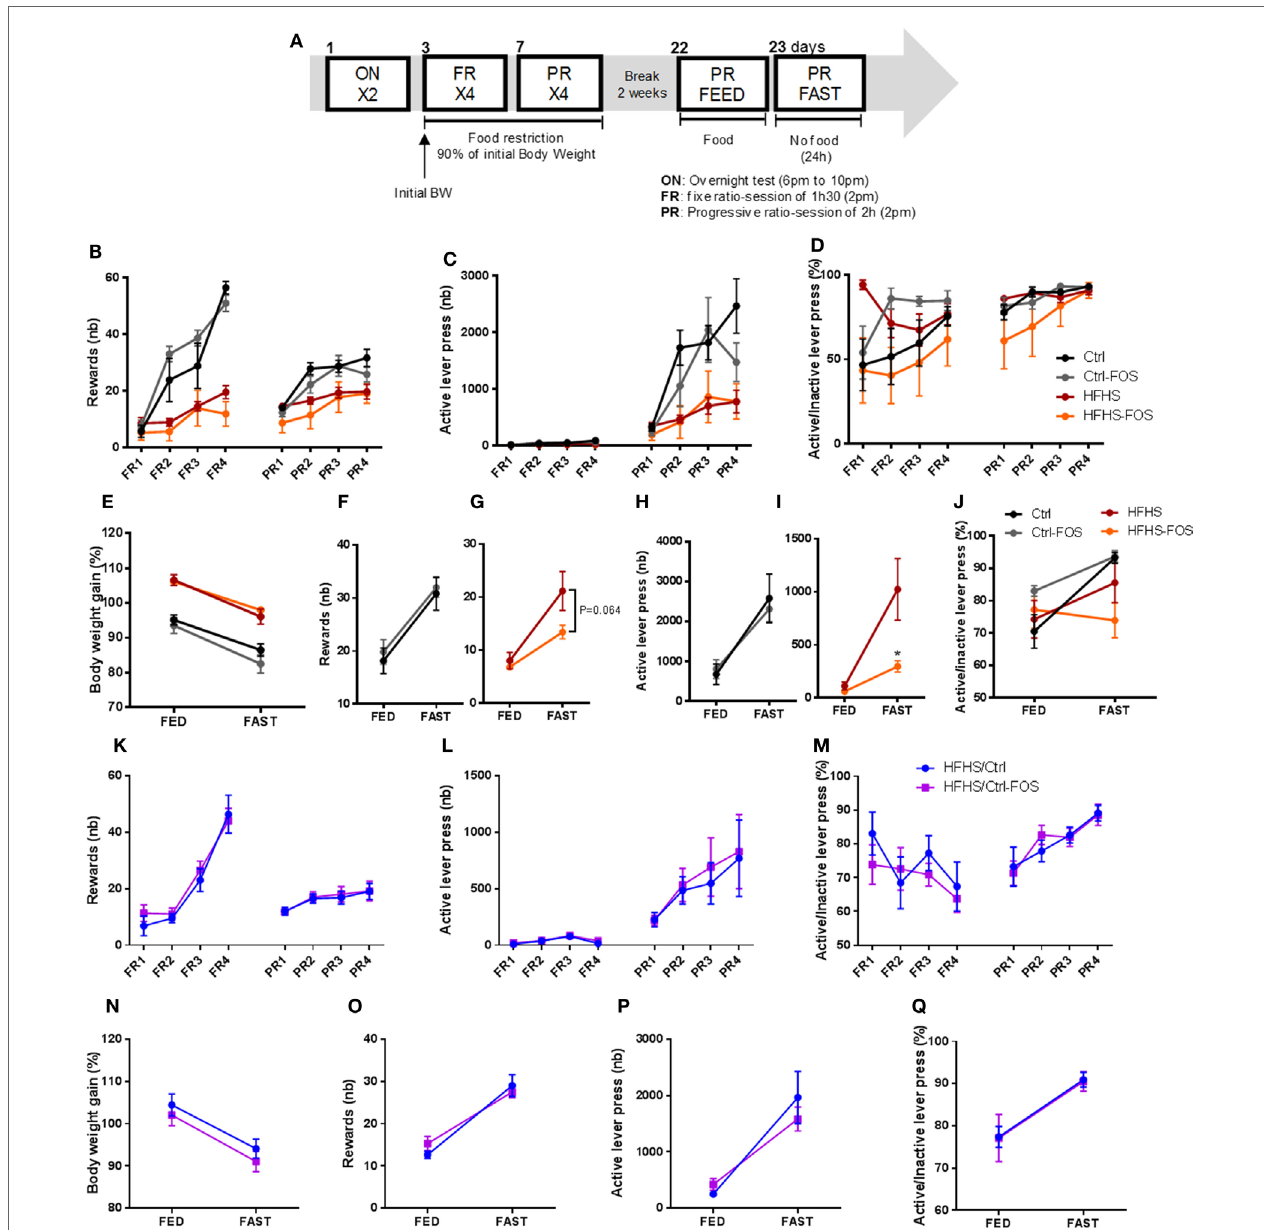
FigUre 3 | (a) Experimental design for the operant responding performance assessment for six mice per group. (B,K) Reward number, (c,l) active lever press, (D,M) ratio between the active and inactive lever presses in (B–D) Ctrl (black), Ctrl-fructo-oligosaccharides (FOS) (gray), HFHS (red), (K–M) HFHS-FOS (orange), HFHS/Ctrl (blue), and HFHS/Ctrl-FOS (purple) during a 90% body weight reduction. (e,n) body weight change, reward number (F,g,O) , active lever press (h,i,P) or active vs inactive lever press ratio (J,Q) in response to an overnight fast in Ctrl (black), Ctrl-FOS (gray), HFHS (red), HFHS-FOS (orange), HFHS/Ctrl (blue), and HFHS/Ctrl-FOS (purple). Data are expressed as mean ± SEM of six mice per group. Significant differences from a two-way ANOVA, Bonferroni Post hoc test are shown (* P < 0.005) (i)